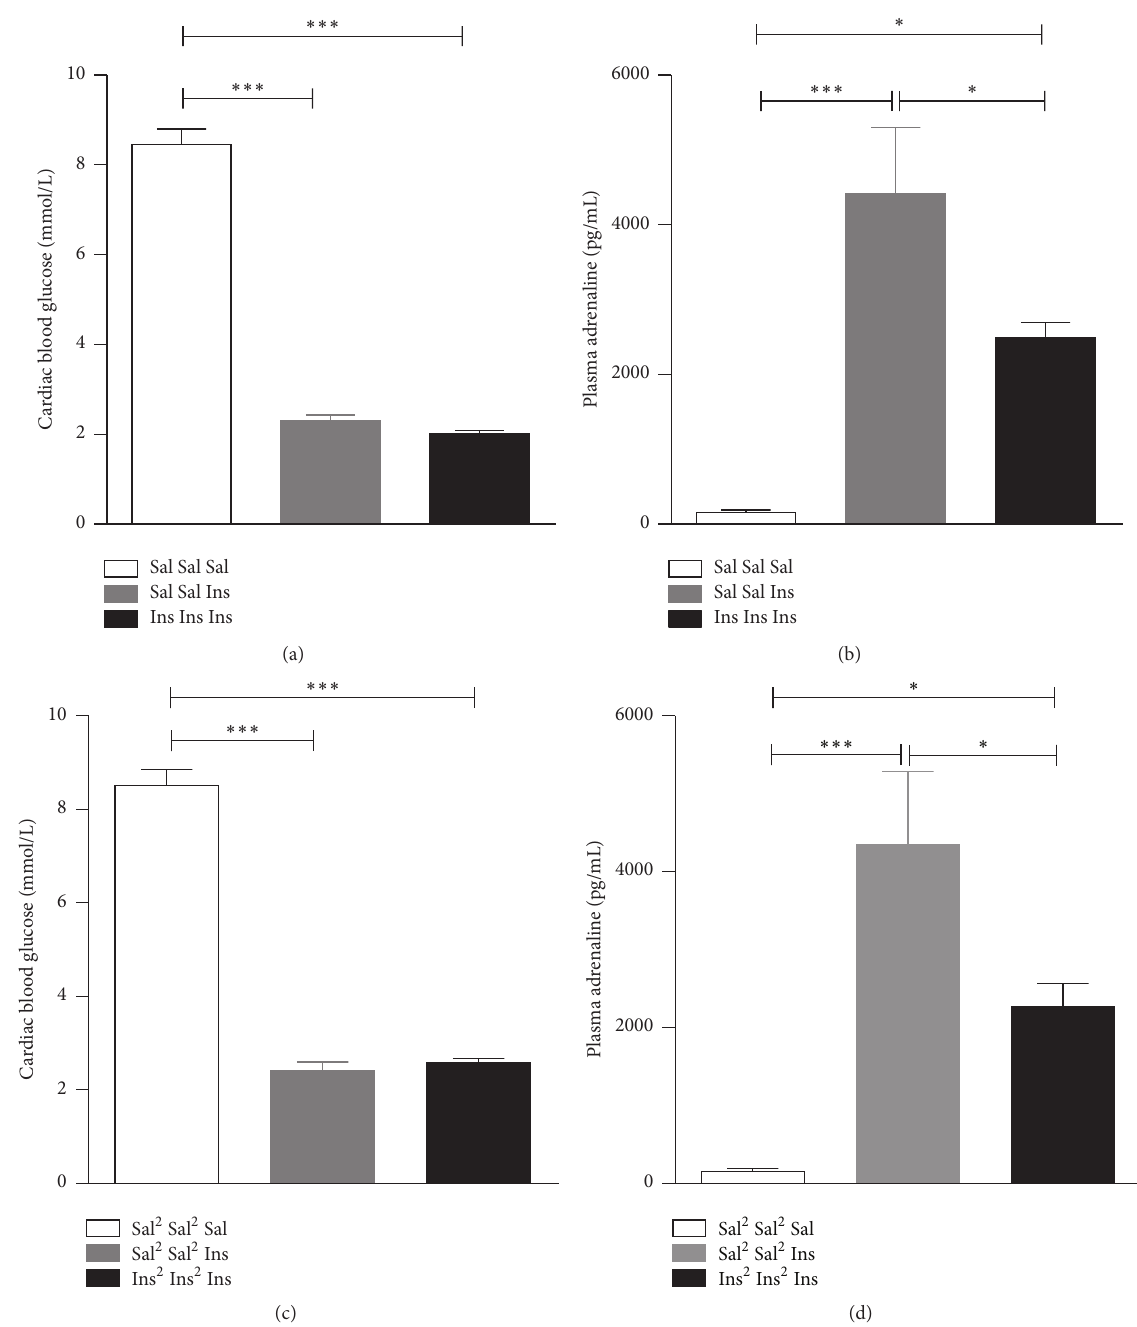
Figure 3: Cardiac blood glucose (a, c) and plasma adrenaline (b, d) levels in rats exposed to saline (white bars), single hypoglycaemia (grey bars), or recurrent hypoglycaemia (black bars). In the recurrent hypoglycaemia groups, rats were exposed to one (a, b) or two episodes (c, d) of antecedent hypoglycaemia per day for two consecutive days followed by an additional episode of hypoglycaemia on day 3. Sal or Sal 2 : saline given once or twice a day, respectively; Ins or Ins 2 : insulin given once or twice a day, respectively. Data are presented as mean ± SEM. ∗ 𝑝 < 0.05 ; ∗∗∗ 𝑝 < 0.001